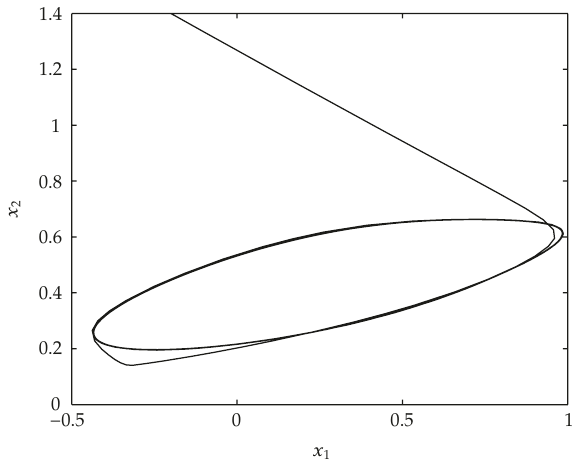
Figure 2: Phase trajectories of system (cid:6) 4.1 (cid:7)